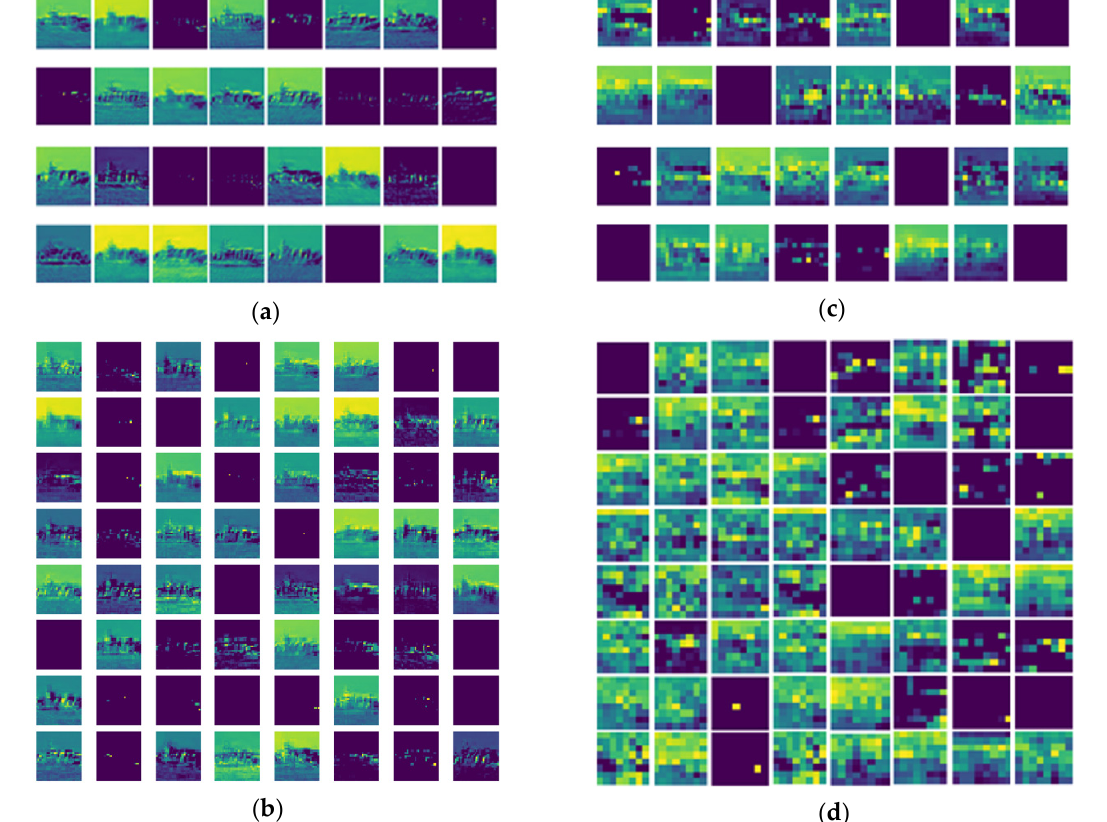
Figure 4. Visualization of feature maps within different convolutional layers: ( a ) First; ( b ) second; ( c ) third; and ( d ) fourth.